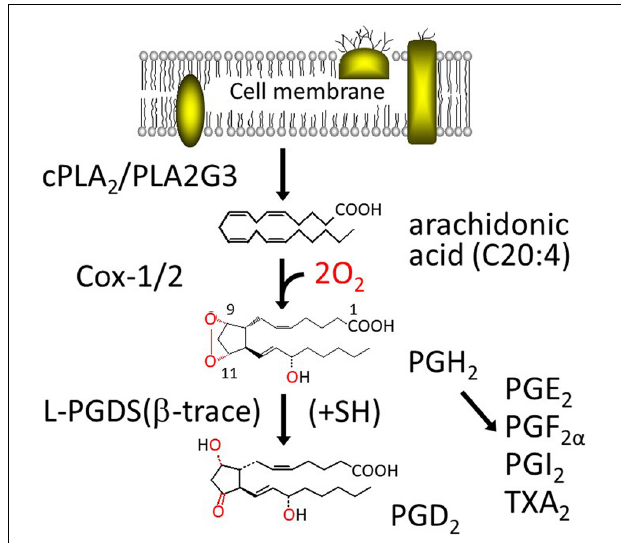
FIGURE 1 | Biosynthesis pathway of PGD 2